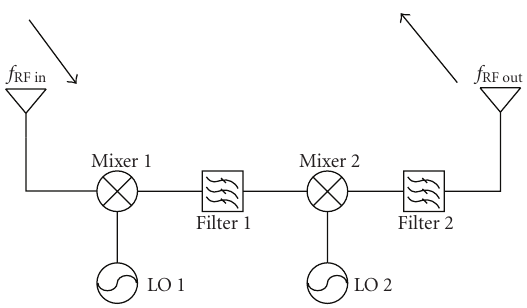
Considering the uninterrupted carrier and the require- ment of the communication, a multichannel structure is used. A power divider is introduced in the RF or IF path to separate the incoming signals that the retrodirectivity and the modulation can be achieved at the same time. This is the common form of the retrodirective array for full-duplex communication